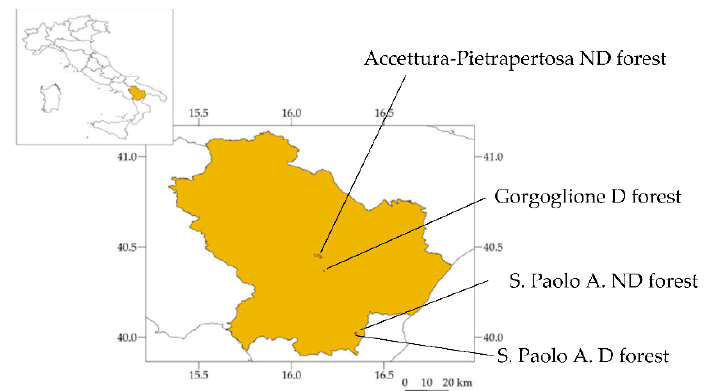
Figure 2. Basilicata region. The geographical position of the decaying (D) and non-decaying (ND) forests analyzed in this paper, in the municipality of Gorgoglione, Accettura-Pietrapertosa, and San Paolo Albanese. Details of such forests are in Figures 3 and 4.